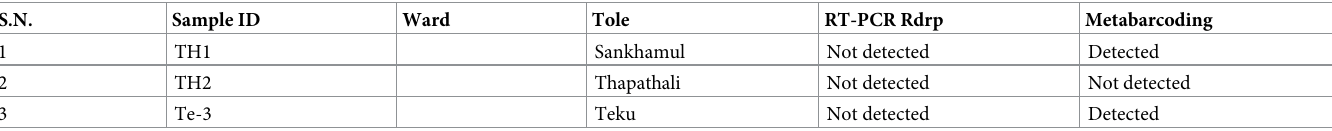
Table 1. Sample details of initial feasibility